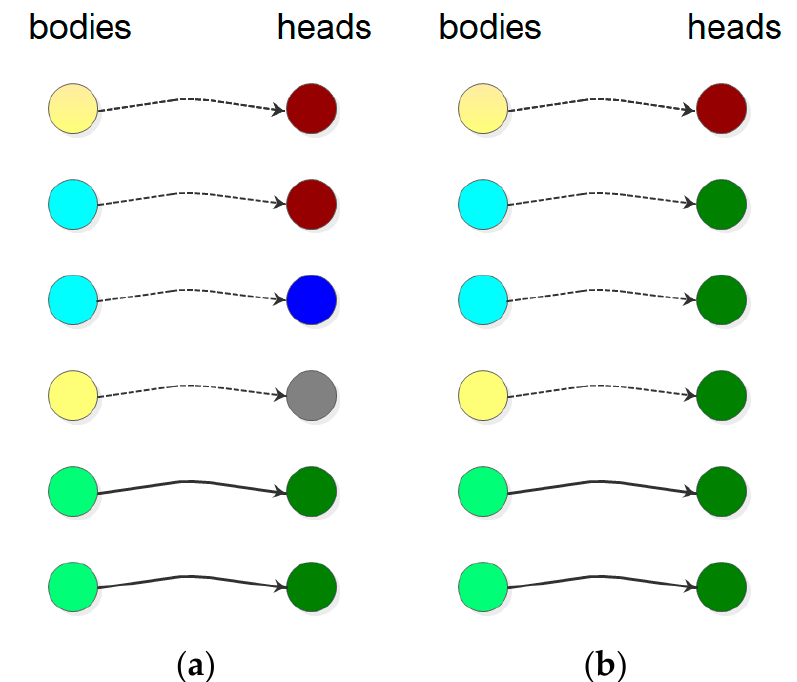
Figure 4. Two different exemplary datasets ( a , b ) with the rules of the same confidence of 100% and support of 33.3%. The rule: if light green, then dark green. The next issue is assessing the rules of low confidence. Please observe the two examples illustrated in Figure 5.